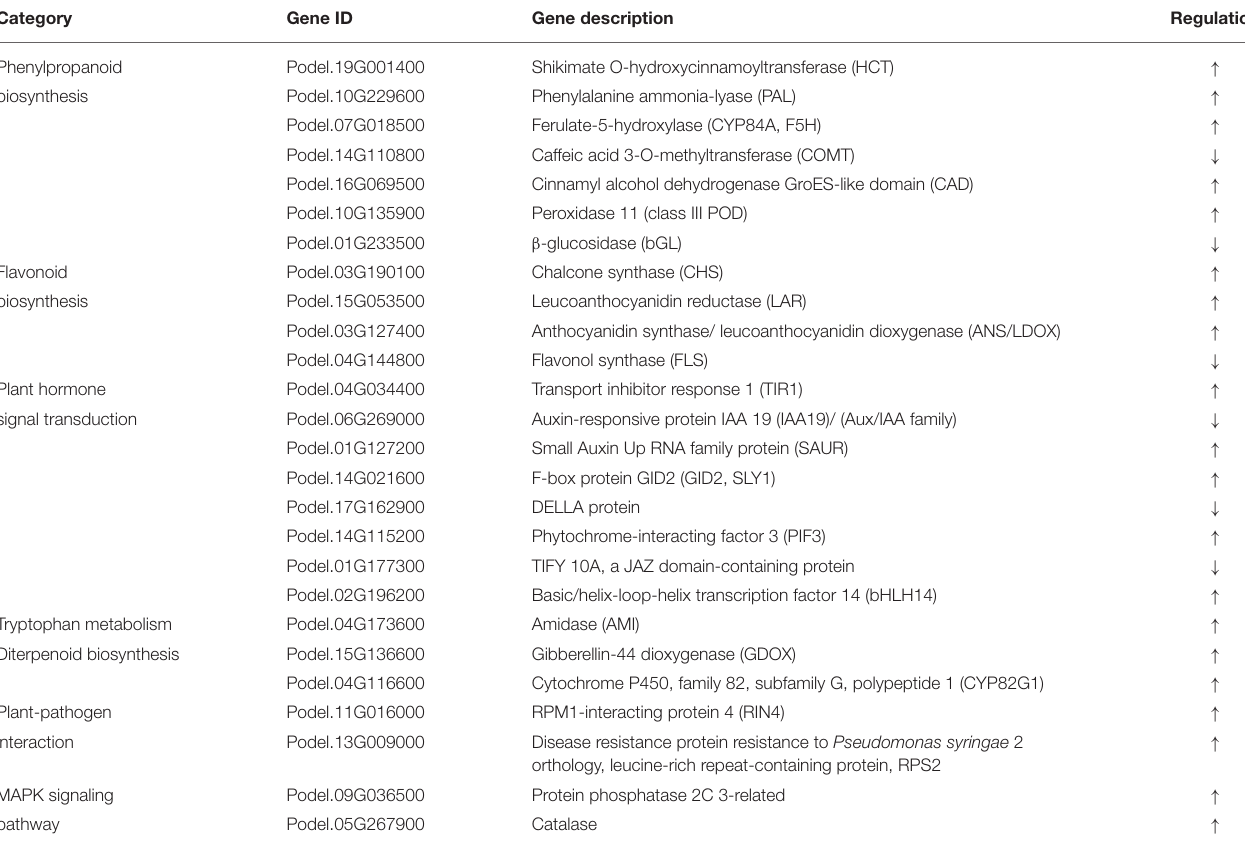
TABLE 1 | Potential genes may be involved in poplar response to Marssonina brunnea